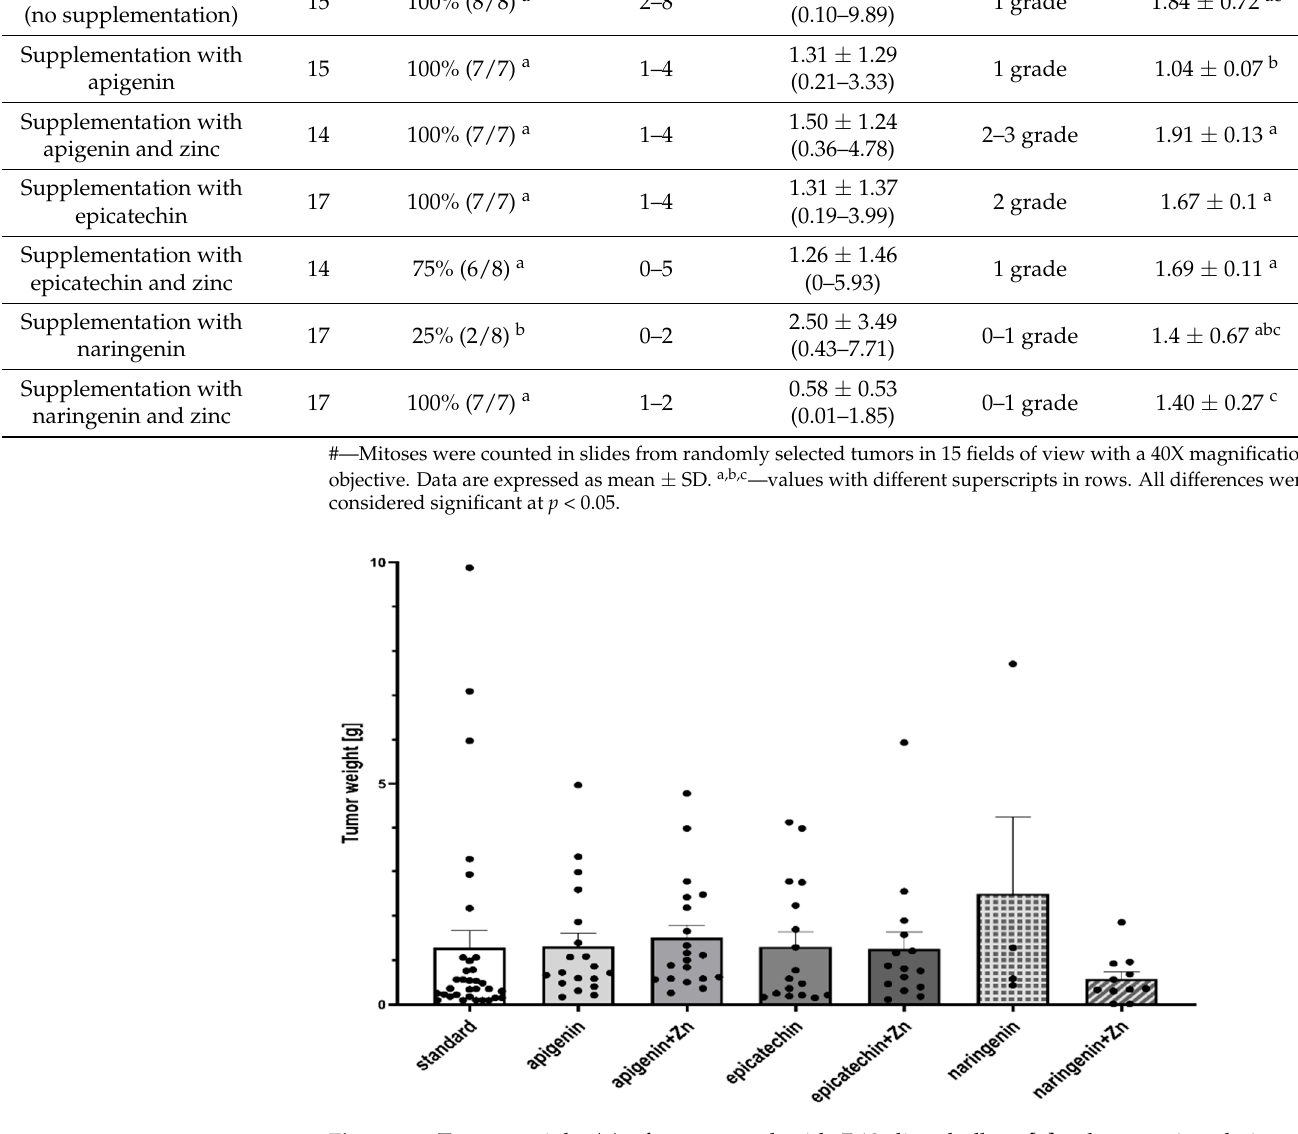
Figure 2. Tumor weight (g) of rats treated with 7,12-dimethylbenz[a]anthracene in relation to supplementation. There is no significant difference between groups.